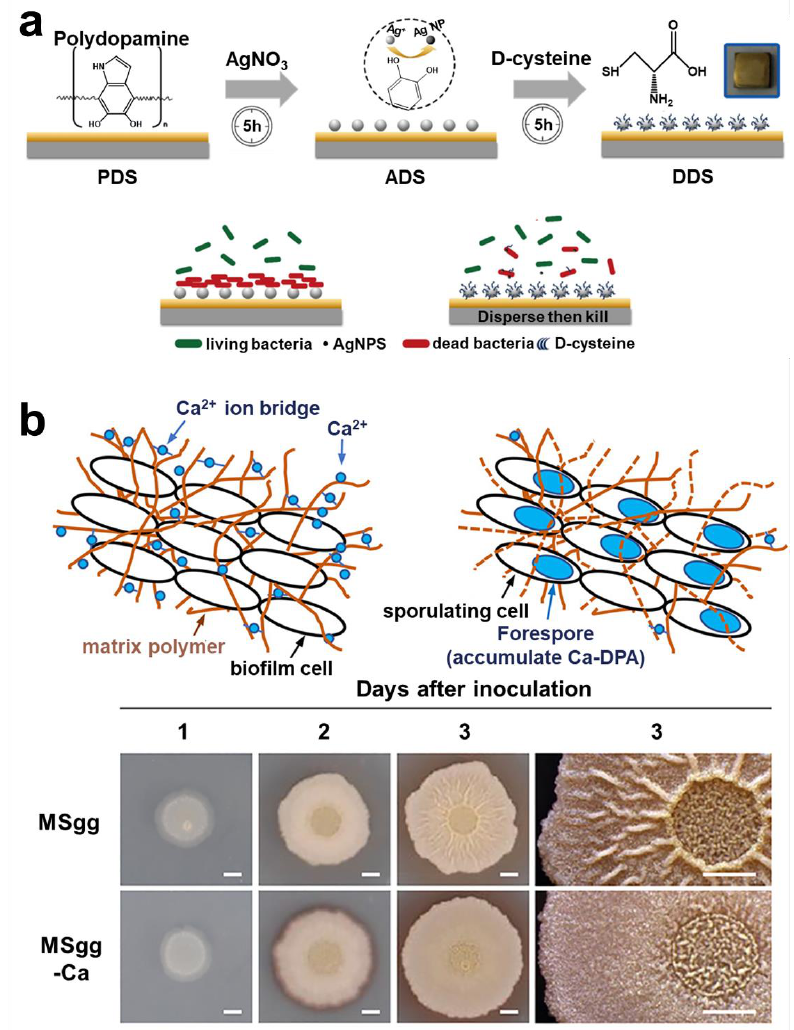
Figure 13. Targeting technology and regulation technology of biofilm dispersion stage. ( a ) The therapeutic strategy of using D-type amino acids to achieve antibacterial and dispersive functions. Reprinted with permission from Ref. [249]. Copyright 2020, Dawei Zhang. ( b ) The strategy of using calcium ions to regulate the biofilm and prevent it from entering the dispersion stage. Reprinted with permission from Ref. [253]. Copyright 2021, Kazuo Kobayashi.